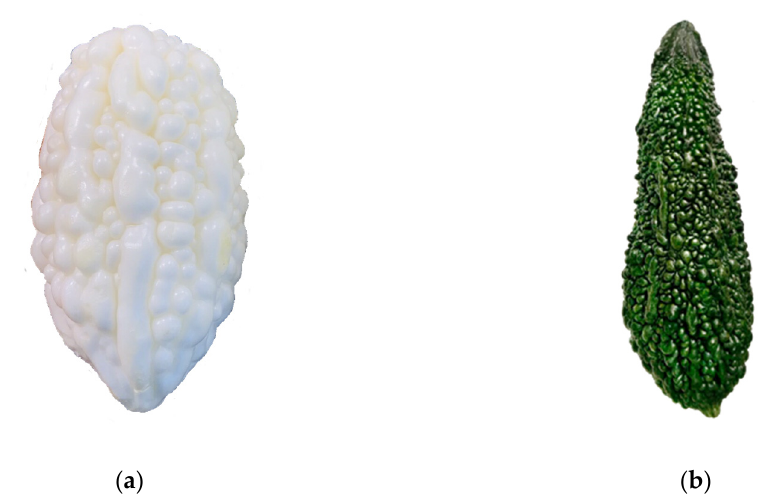
Figure 1. Bitter gourds used in this study. ( a ) Momordica charantia L., ( b ) Momordica charantia L. var. abbreviata Ser.